Question: According to the figure, is the described quantity increasing or decreasing?
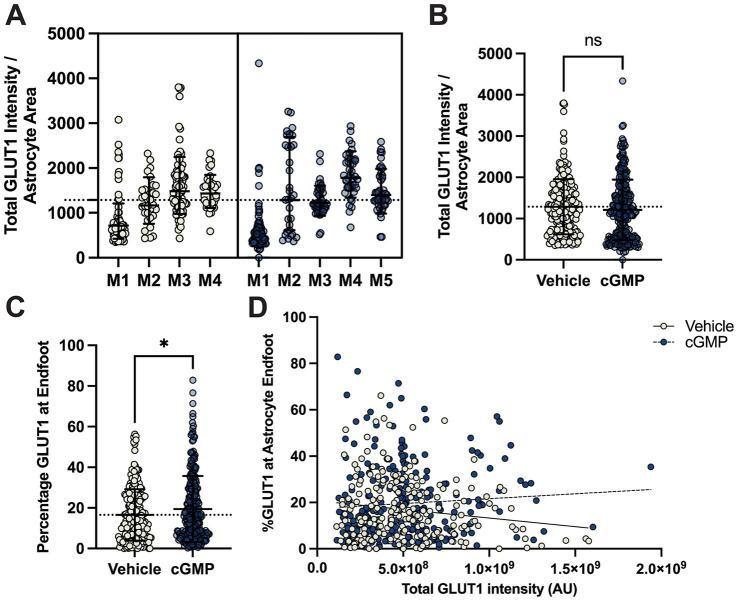
Answer: increasing